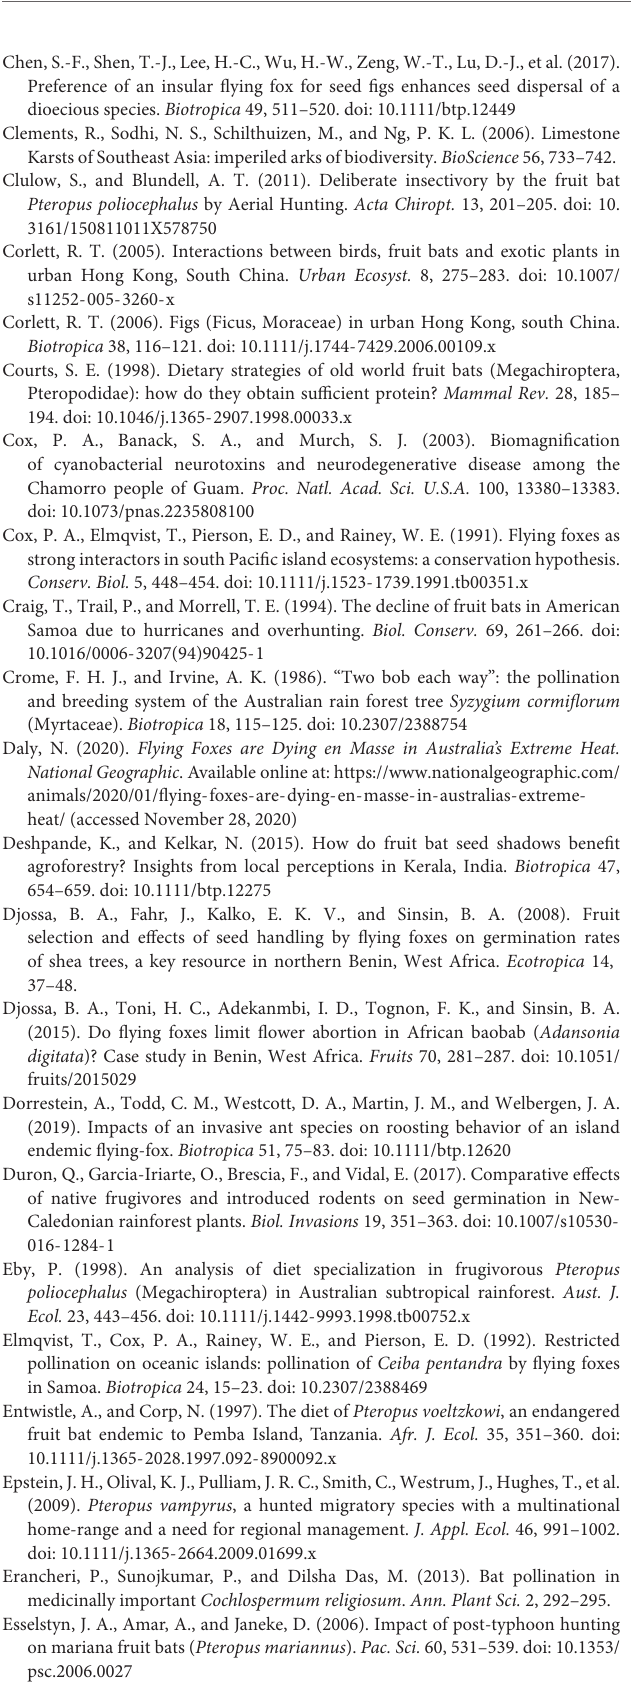
Frontiers in Ecology and Evolution |